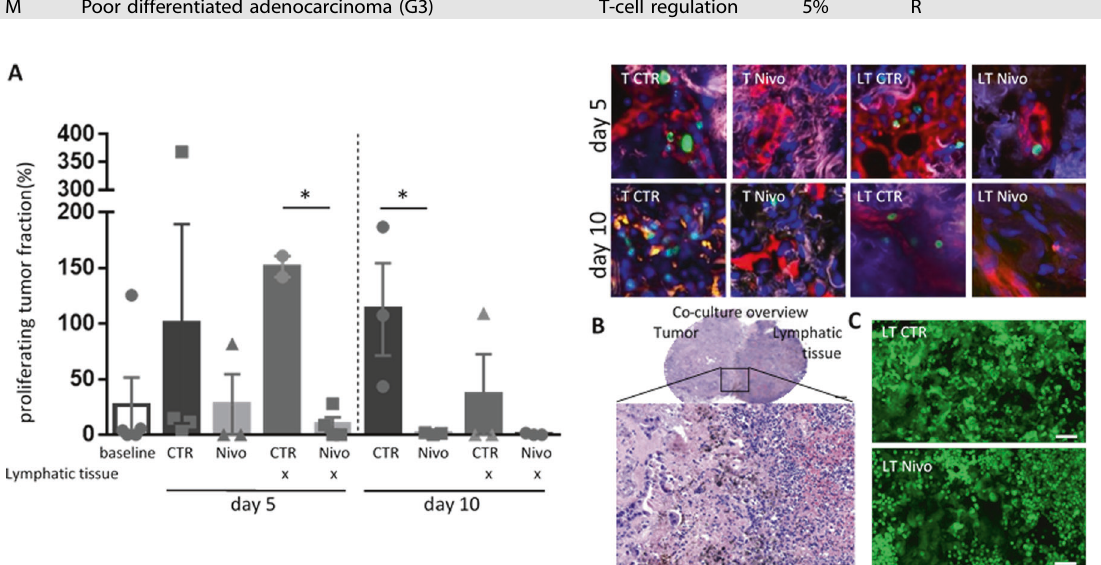
Fig. 2 Nivolumab tissue response is independent of lymphocyte supplementation. NSCLC tissue cultures were cultivated alone (T) or with autologous lymphatic tissue (LT) in the presence or absence of Nivolumab for 5 or 10 days. A Percentages of Ki67 proliferating tumor fractions in the different culture conditions from one patient specimen are shown upon normalization to the control culture in the absence of lymphocytes (left) Kruskal – Wallis test showed signi fi cant differences. Representative pictures of the different conditions at day 5 and 10 are shown (right). pancytokeratine, red; Ki67, green; Hoechst, blue; background, white. Bar = 50 µm. B Shown is the HE staining of a NSCLC tissue co-cultured with lymphatic tissue slice at day 10. Overview, bar = 500 µm; HE magni fi cation, bar = 50 µm. C Calcein live staining (green) of a control tissue (top) and a nivolumab treated tissue (bottom) after 5 days in co-culture with lymphatic tissue. Bar = 200